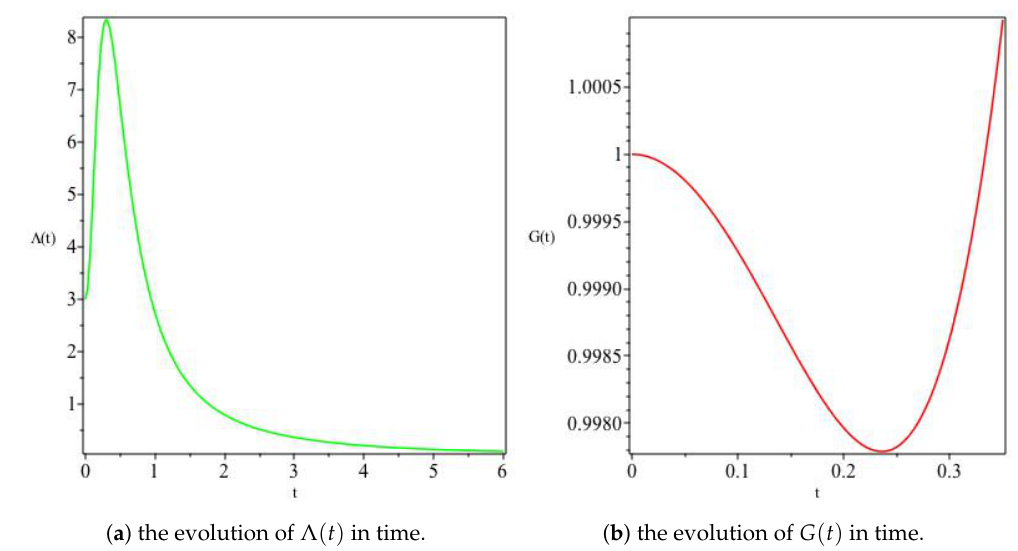
Figure 8. The variation of Λ and G for Model I. Panel ( a ) shows an initially positive Λ increasing towards a finite maxumumm value and eventually vanishingly decreasing. Panel ( b ) shows figure drawn so as to zoom in the decreasing behaviour of G for small t, increasing for large t.